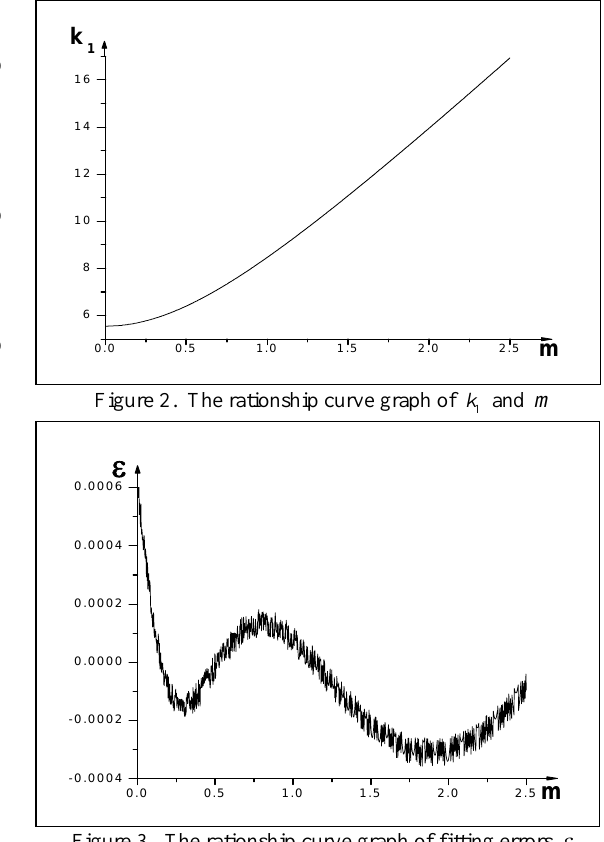
Figure 3. The rationship curve graph of fitting errors ε (equation (15)) and